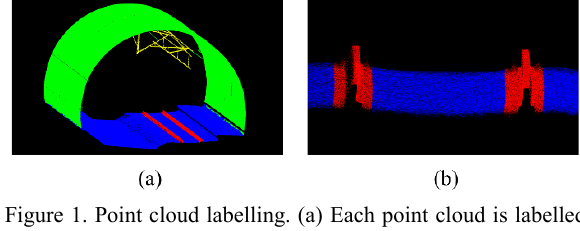
Figure 1. Point cloud labelling. (a) Each point cloud is labelled defining four classes, namely ground (blue), lining (green), rails (red) and wiring (yellow). (b) Mislabelling may occur in their boundaries. In this case, between rails and ground